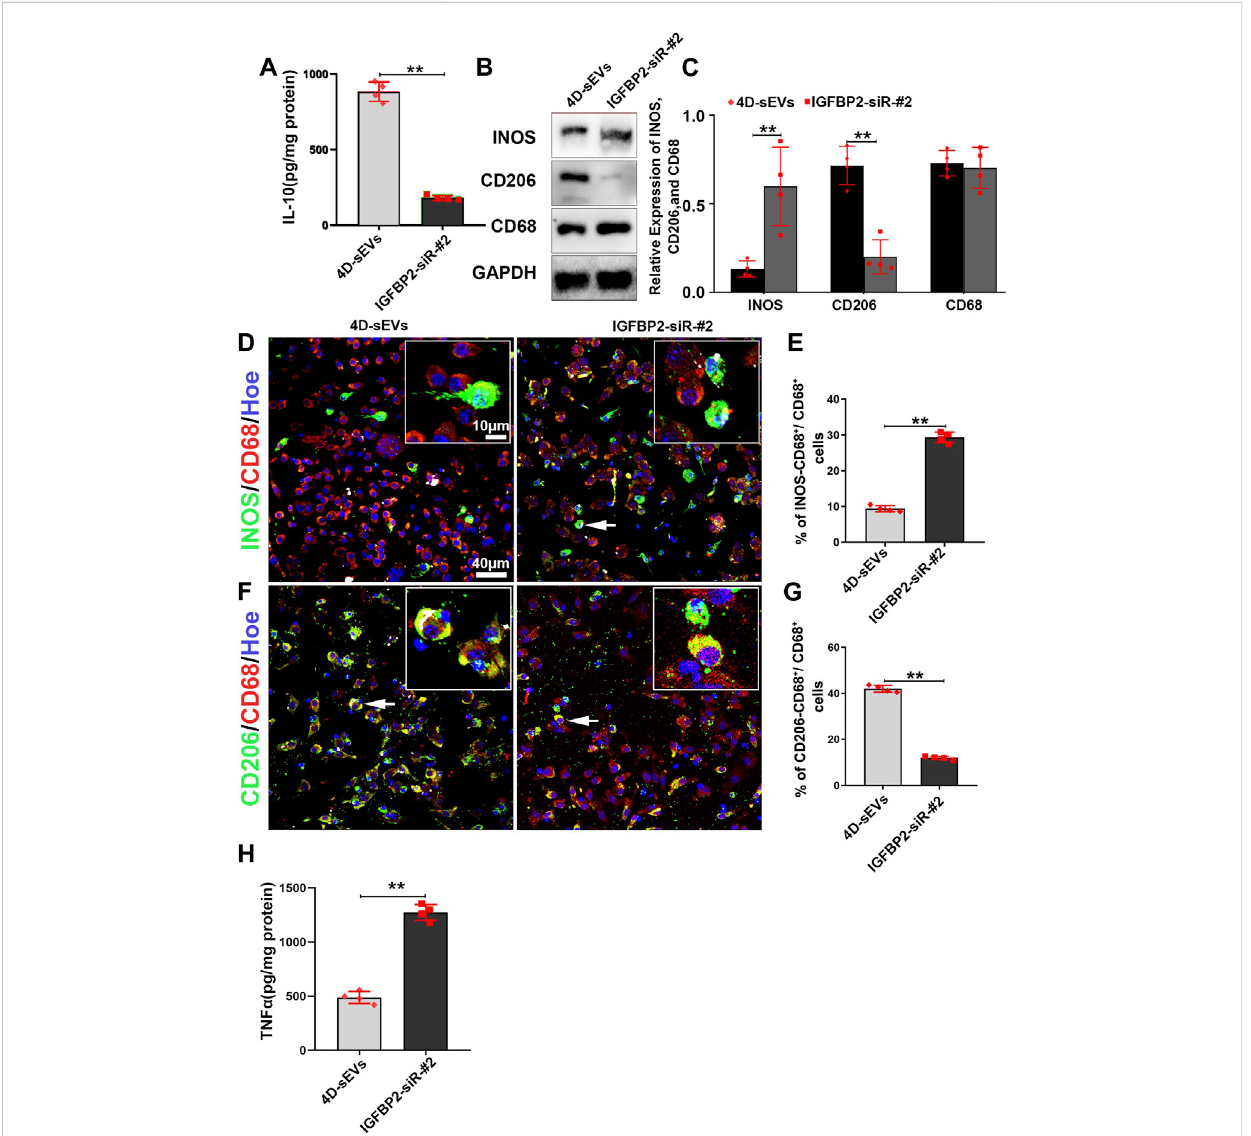
FIGURE 7 Interfering with the IGFBP2 protein expression inhibits M1 to M2 polarization of macrophages in vitro . (A) ELISA was performed to detect the concentrations of IL-10 from the supernatant of RAW264.7 cells. (B) Western blot analysis of protein expression (INOS, CD206, CD68). (C) Quantitative analysisofWesternblot. (D) FluorescentlystainedimagesshowingINOS + (green)/CD68 + (red)M1macrophagecellsintwogroups. (E) Barchartsshowing that the ratio of INOS + /CD68 + cells to CD68 + cells. (F) Fluorescently stained images showing CD206 + (green)/CD68 + (red) M2 macrophage cells in twogroups. (G) Bar charts showingthat theratio ofCD206 + /CD68 + cells to CD68 + cells. (H) ELISAwas performedto detect theconcentrationsof TNF- α from the supernatant of RAW264.7 cells. Statistic difference: ** p <